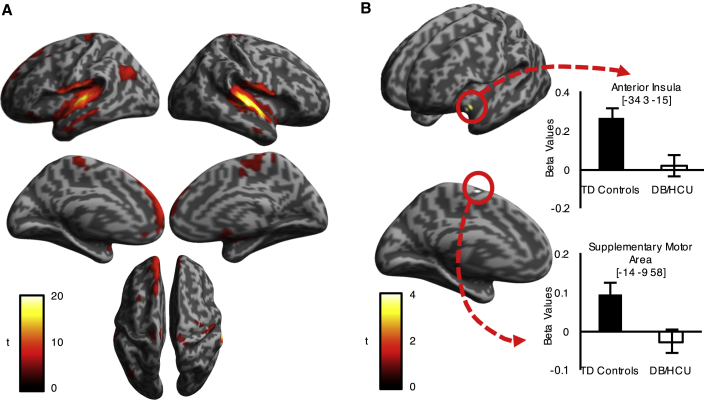
Neural Responses to Laughter across All Participants and Differences between Groups(A) Responses to genuine laughter versus rest across all participants, N = 93, p < 0.001 peak level uncorrected, family-wise error (FWE) corrected (p < 0.05) at cluster level. See also Table S1.(B) Responses to genuine laughter (versus rest) in typically developing (TD) boys versus boys with disruptive behavior and high callous-unemotional traits (DB/HCU) (thresholded at p < 0.05 small-volume corrected FWE). See also Table S3. Error bars represent the standard error of the mean.